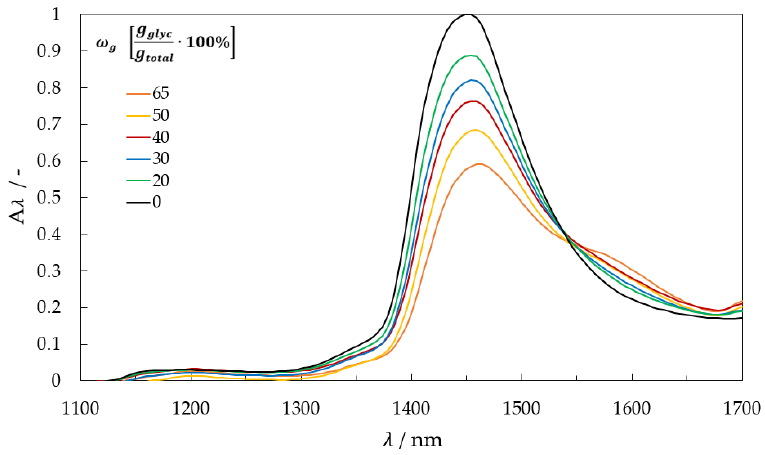
Figure 1. Near-infrared spectra of pure water, glycerol, and glycerol-water mixtures